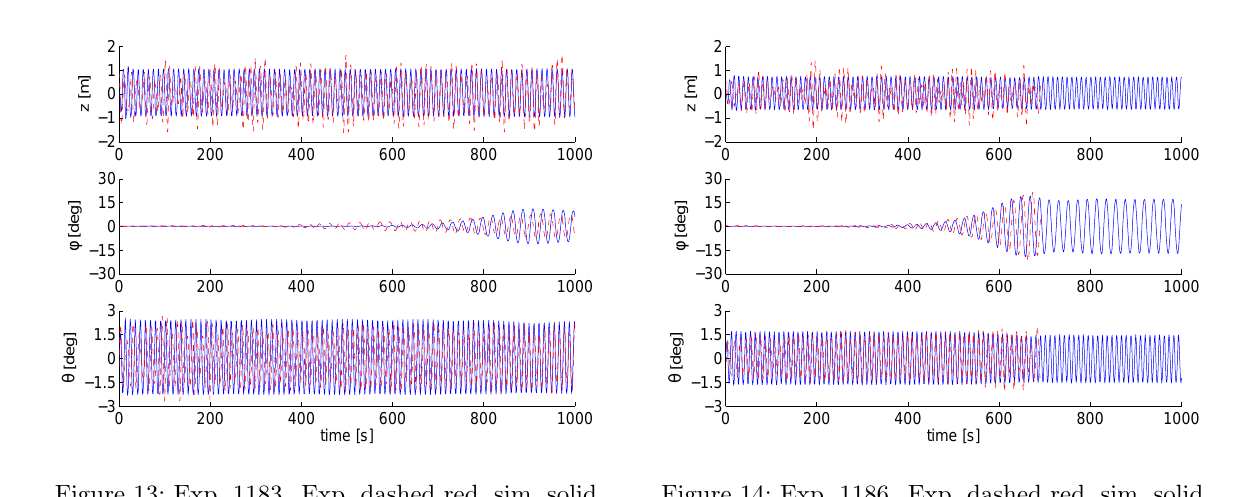
Figure 13: Exp. 1183. Exp. dashed red, sim. solid blue.